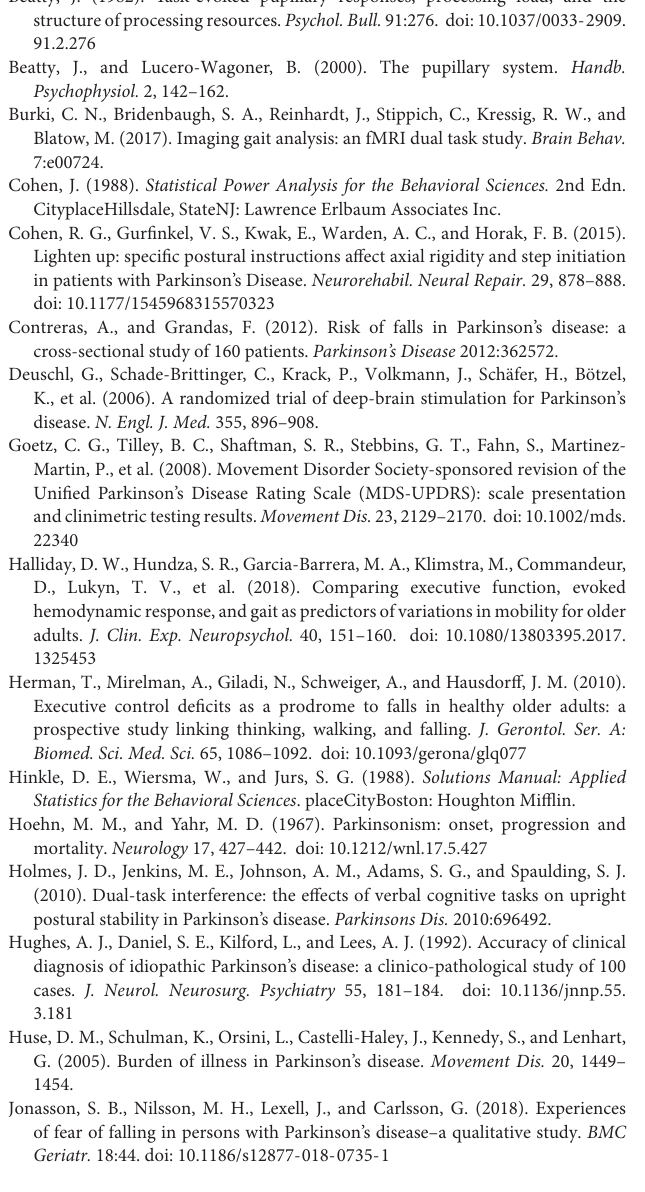
accross the conditions. * p < 0.01.